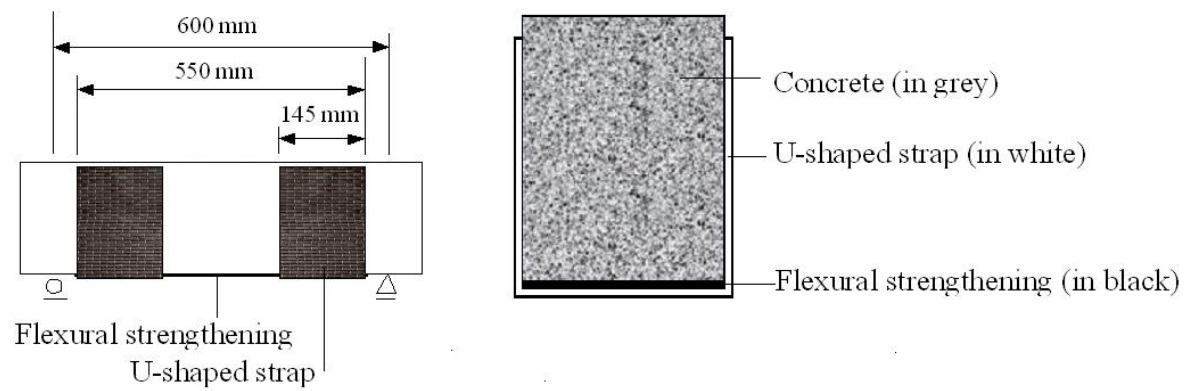
Figure 2. Details of composite strengthening scheme.